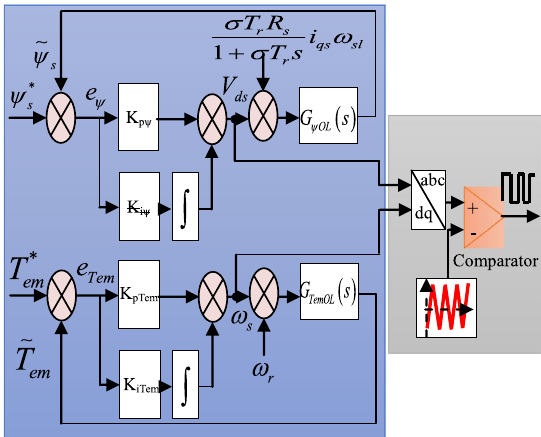
Fig. 6 Stator flux and electromagnetic torque regulating